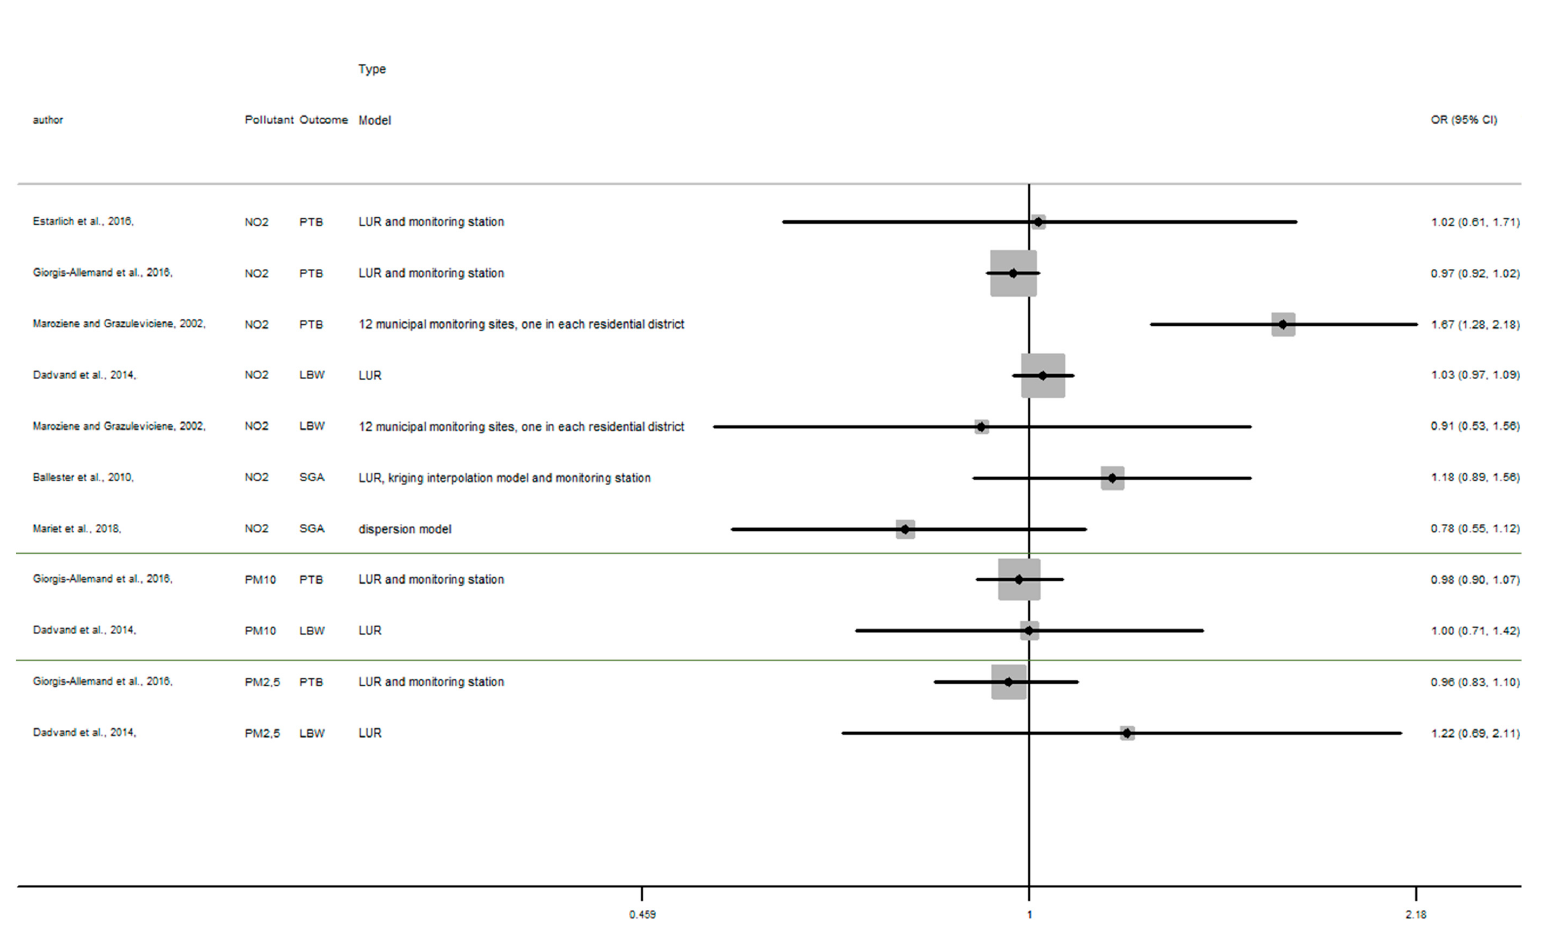
Figure A2. Risk of birth outcome for air pollutant exposure during first trimester.